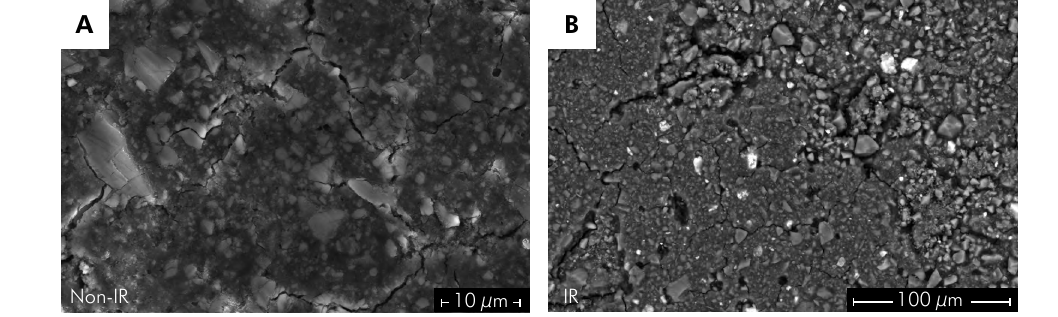
Figure 5. A: SEM photomicrograph of Amalgomer CR in the Non-IR (non-irradiated) subgroup. The photomicrographs were obtained with secondary electrons mode at 15 kV. Cracks were observed on the surface of the specimens; B: SEM photomicrograph of Amalgomer CR in the IR (irradiated) subgroup. The photomicrographs were obtained with secondary electrons mode at 15 kV. Cracks were observed on the surface of the